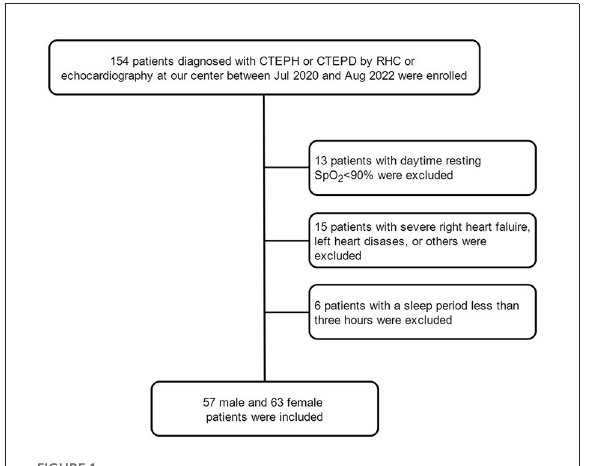
FIGURE1 Flow chart of enrolled patients. CTEPD, chronic pulmonary thromboembolic disease; CTEPH, chronic thromboembolic pulmonary